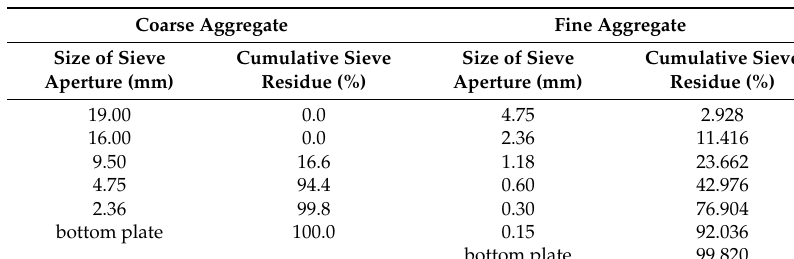
Table 2. Particle size distribution of coarse aggregates.